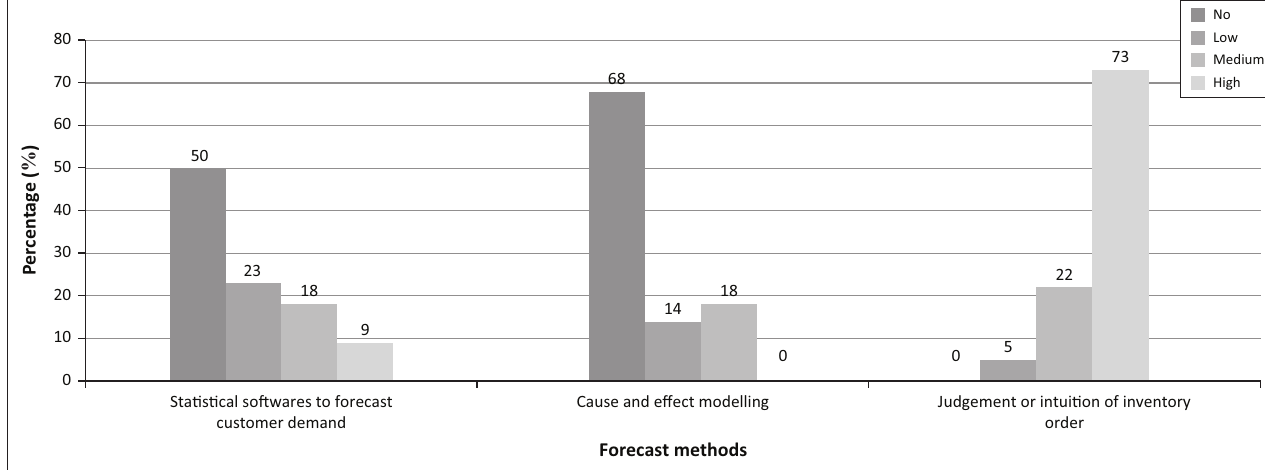
Sta(cid:28)s(cid:28)cal so(cid:22)wares to forecast customer demand